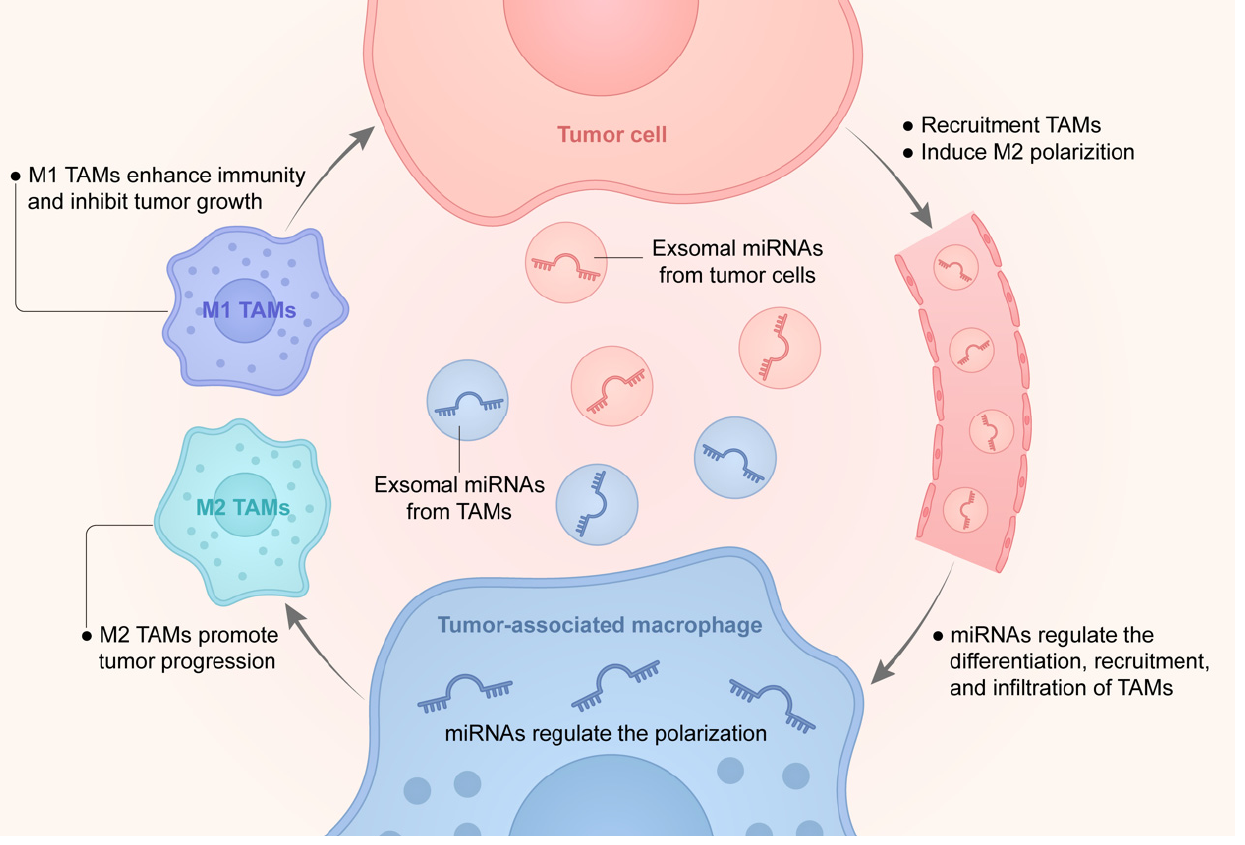
Figure 1. A graphic summary of the interactions among TAMs, tumor cells, and miRNAs.